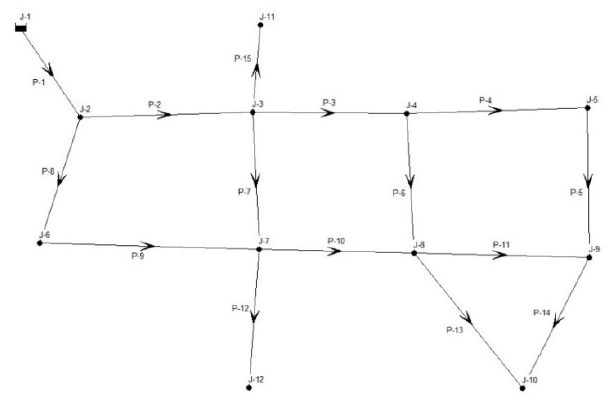
Figure 1. Sample pipe network.